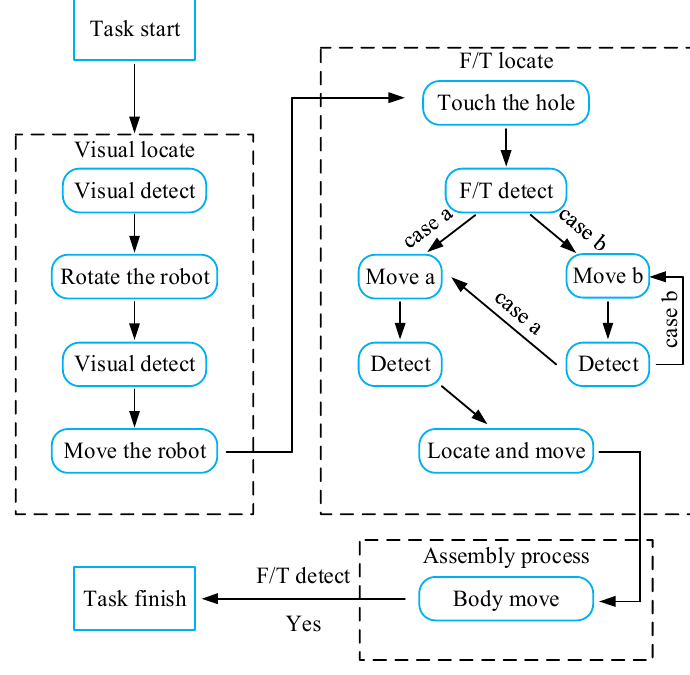
Figure 4. The process of the peg-in-hole task.